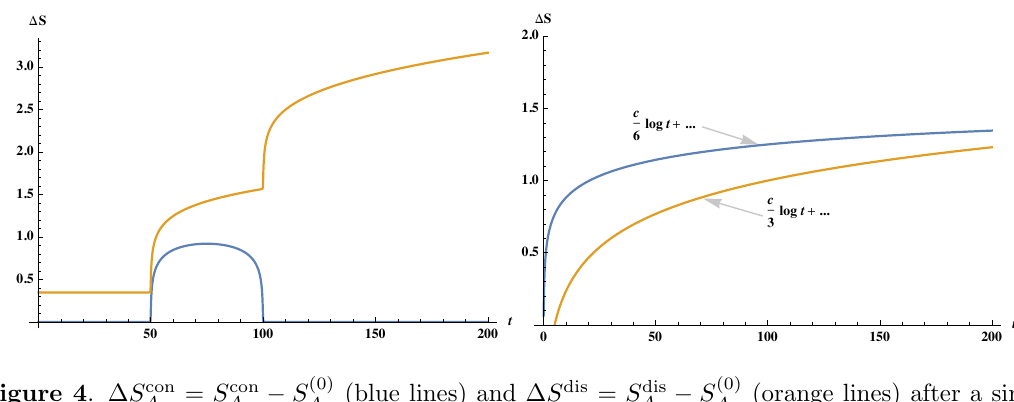
Figure 4 . ∆ S con = S con S (0) (blue lines) and ∆ S dis = S dis S (0) (orange lines) after a single A A − A − A A is the EE of the vacuum state. A = [50 , 100] in joining quench in a holographic CFT, where S (0) A the left figure and A = [0 . 1 , 1000] in the right figure. We set a = 0 . 1 and c = 1. The boundary entropy S bdy is set to be